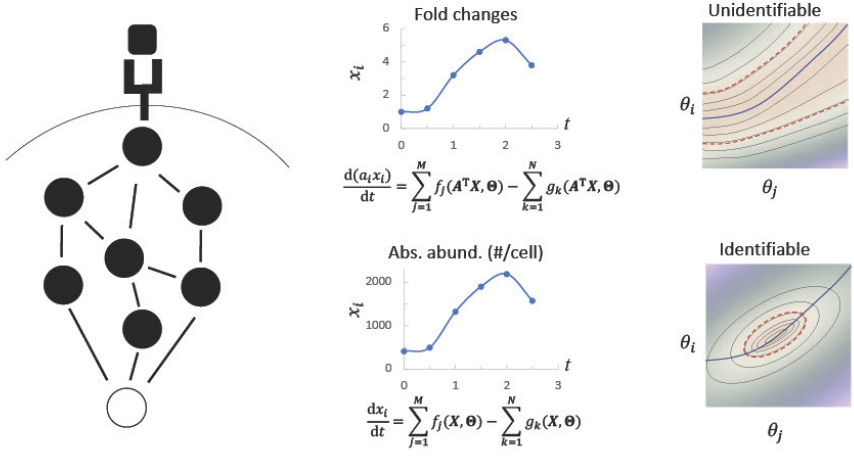
Figure 2. Absolute quantifications increase the identifiability of model parameters.